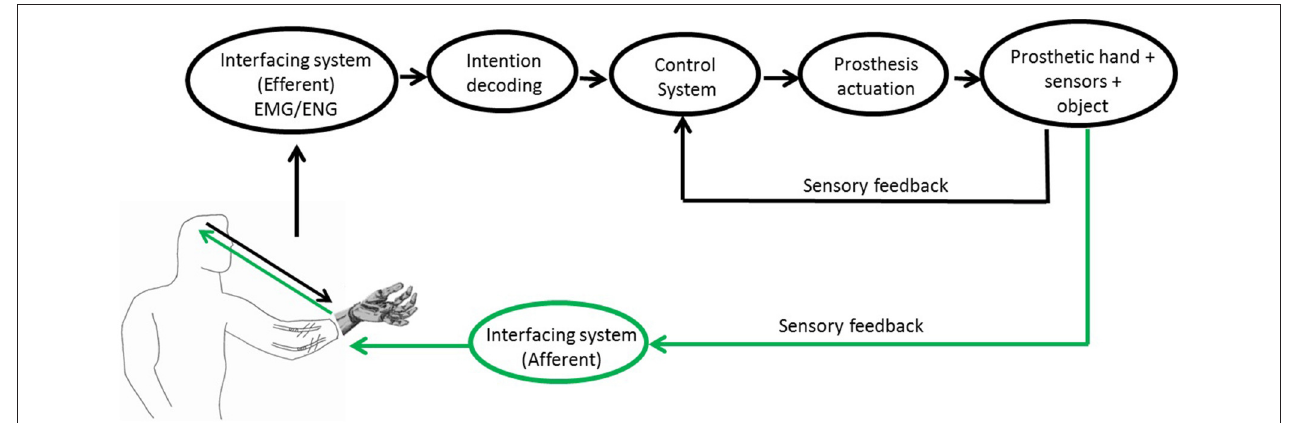
FIGURE 1 | Block scheme of the PNS-based control of a prosthetic system. Readapted from 5 and (Raspopovic et al.,